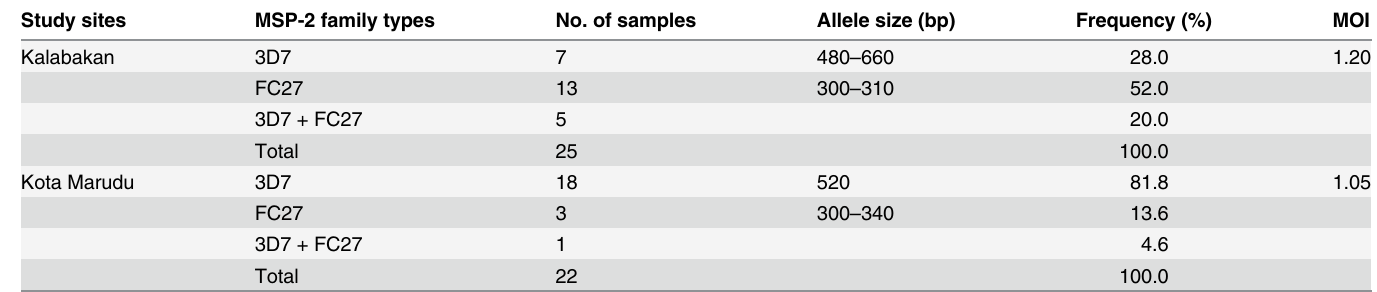
Table 4. Genotyping of P . falciparum MSP-2 polymorphic region block